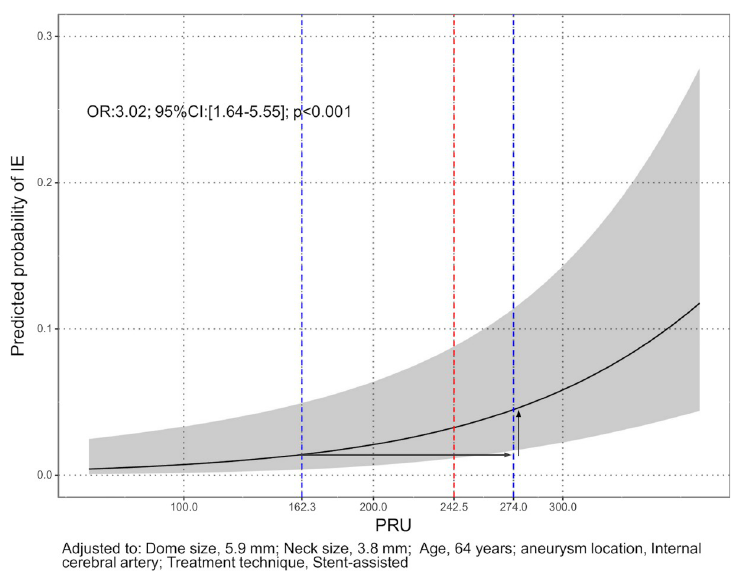
Fig 5. Relationship between the predicted probability of TE and PRU value adjusted for values of the clinical model. Predicted probability of infarction was provided by a multivariable logistic regression model when covariates including age, sex, hypertension, diabetes mellitus, dyslipidemia, smoking, aneurysm dome size, neck size, and aneurysm location were fixed at the median. The gray area indicates the 95% CI of predicted probability by PRU. The arrows indicate, for example, that if there is an increase in PRU from the 25 th percentile (162) to the 75 th percentile (274), the odds of TE increase by approximately 3-fold (Odds ratio: 3.02; 95% CI: [1.64–5.55]; P < .001). Abbreviations: TE, thromboembolic event; CI, confidence interval; PRU, P2Y 12 reaction units.